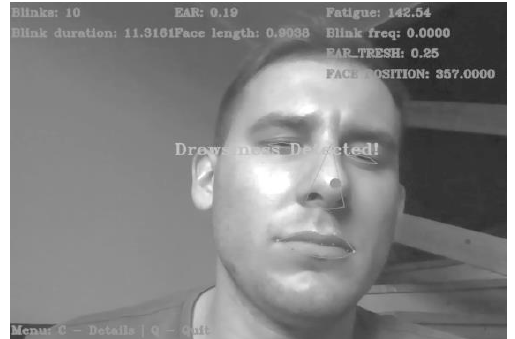
Fig. 7. User’s interface when the driver is